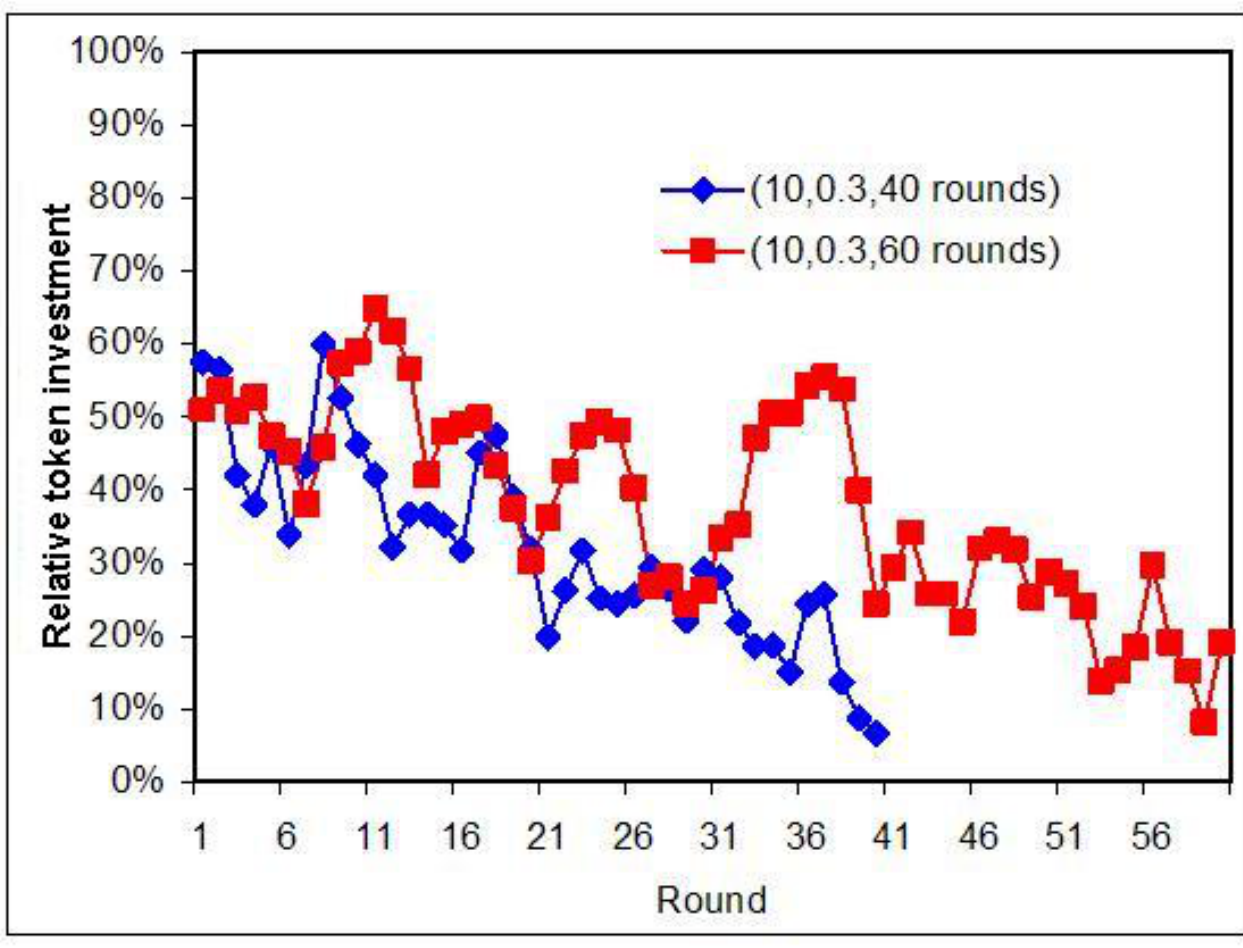
Fig. 2 . Average contribution per round for two different treatments. The number of participants, the marginal per capita return, and the number of rounds are given in